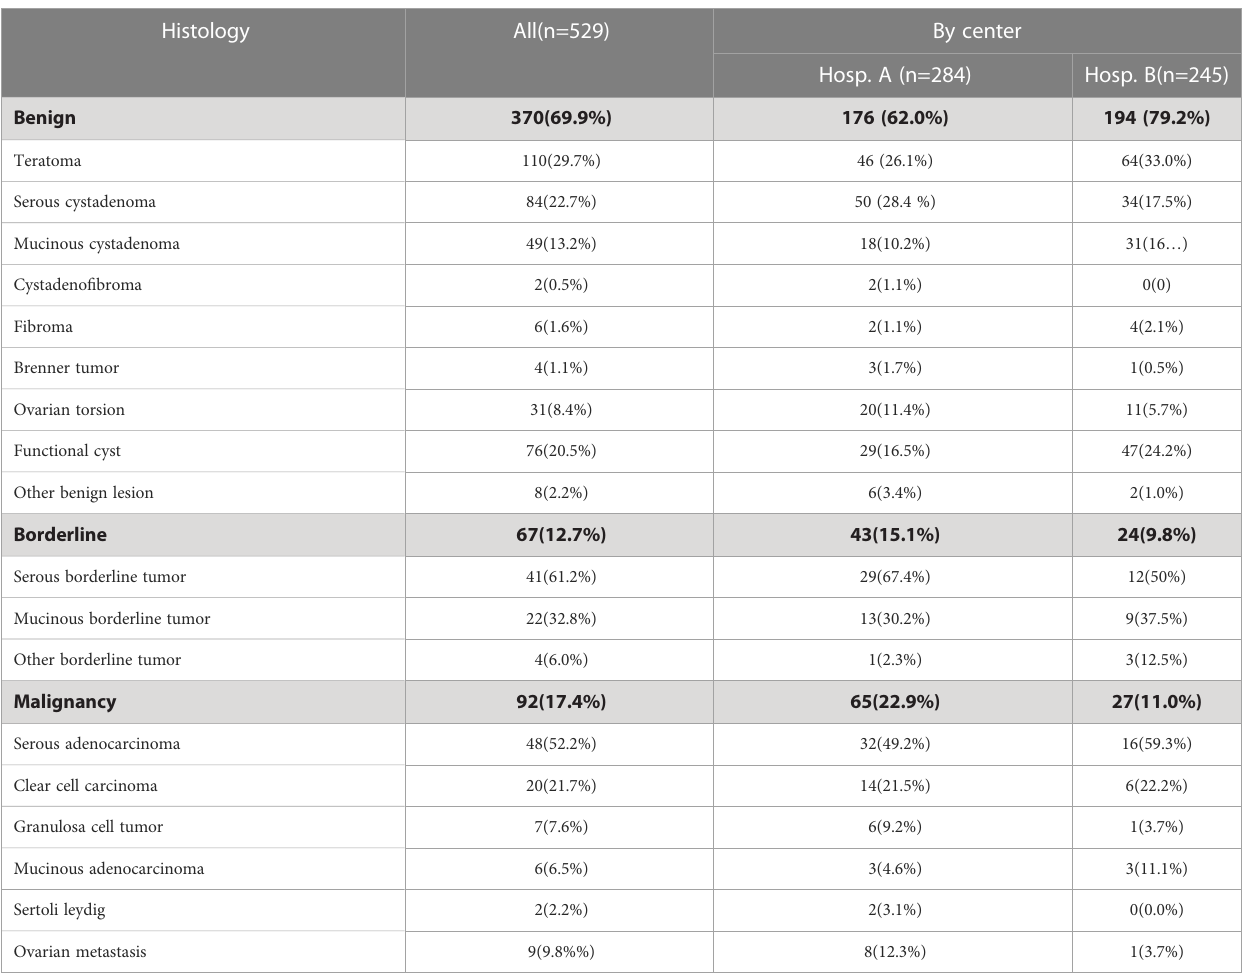
TABLE 1 Histological subtypes of adnexal tumors in patients treated in two